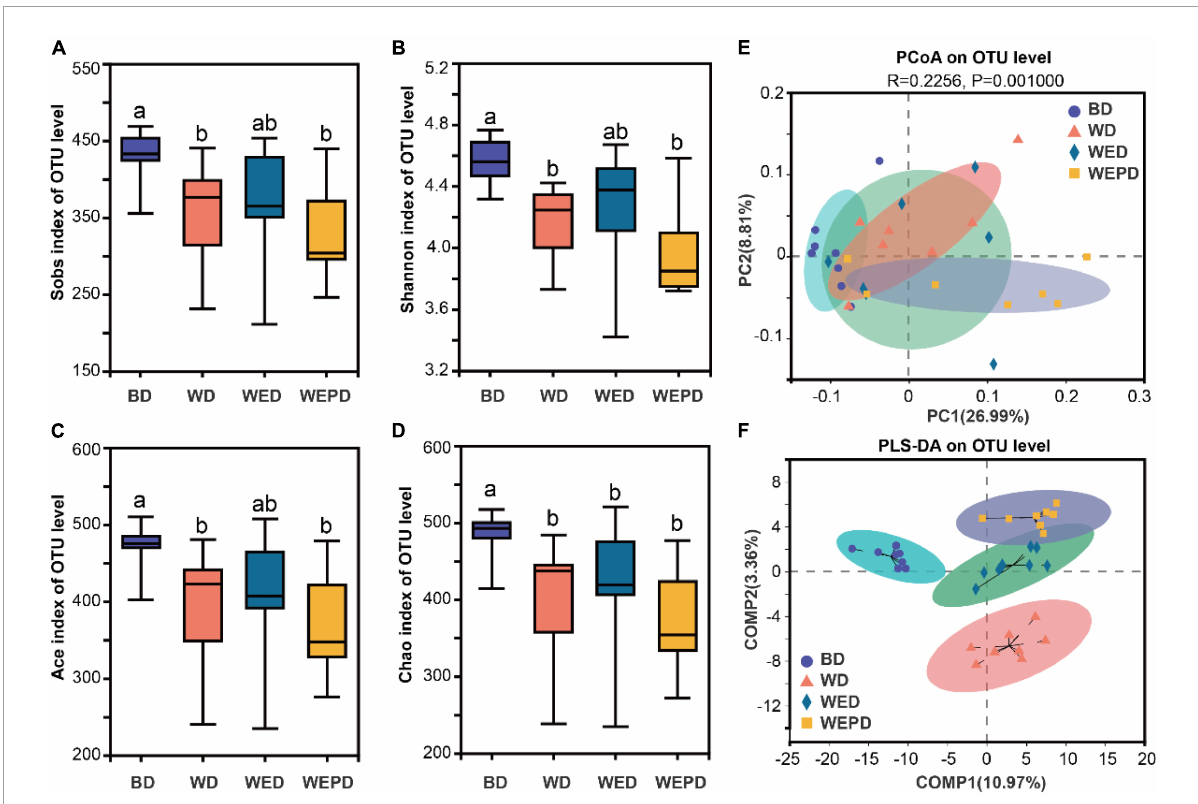
FIGURE2 Alpha and beta diversities of the microbial community in the cecum digesta among different treatments. (A) The Sobs, (B) Shannon, (C) ACE, and (D) Chao indexes in the cecum among four groups; PCoA (E) and PLS-DA (F) of microbial community based on unweighted UniFrac and ANOSIM test in cecum digesta. Different letters (a, b) means significant differences ( P <